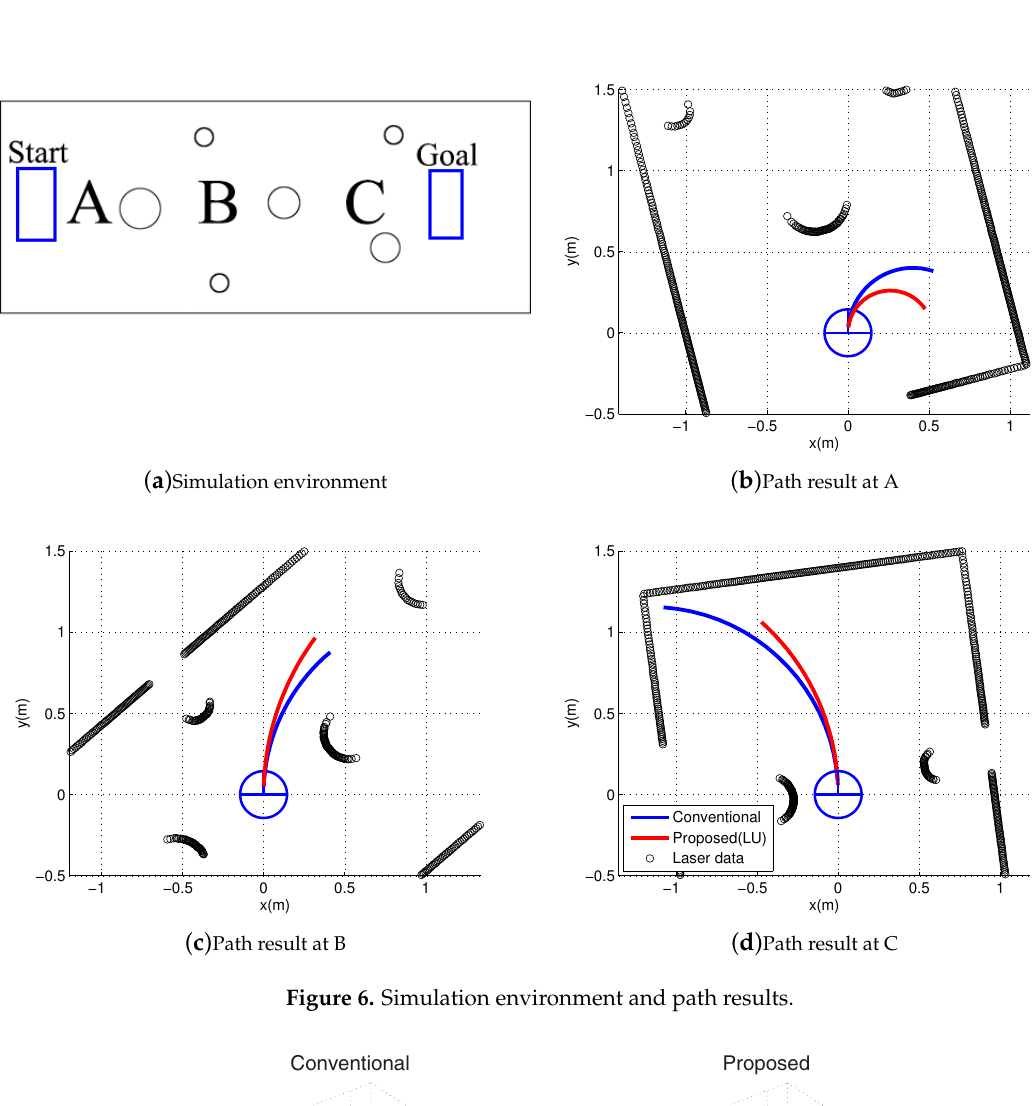
Figure 6. Simulation environment and path results.